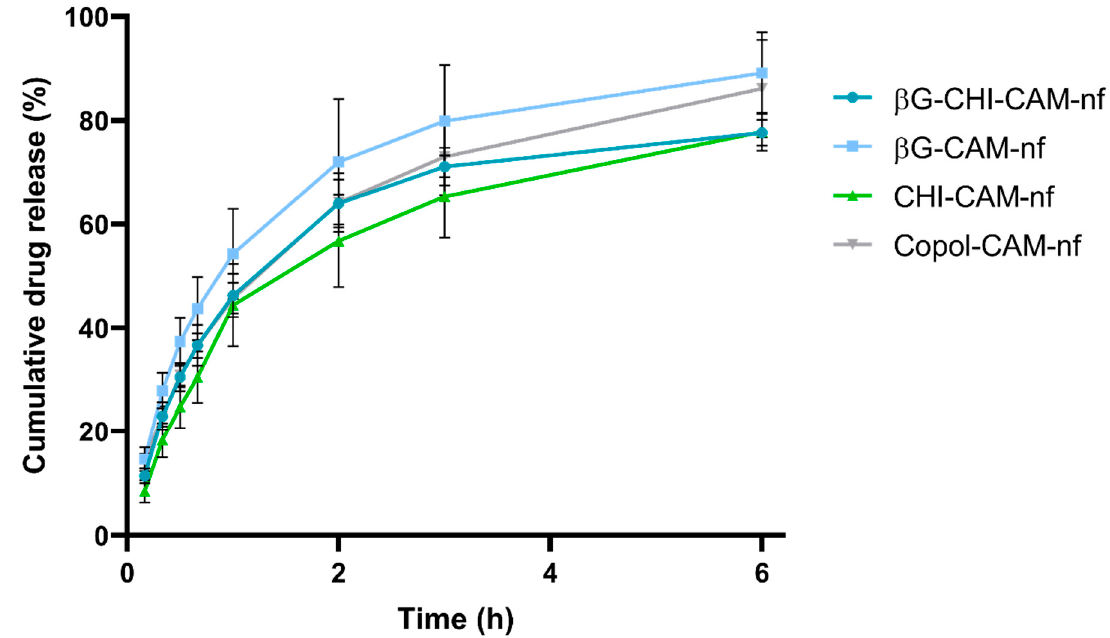
Figure 2. Cumulative release (%) of chloramphenicol from nanofibers during a 6 h test-period in a Franz diffusion setup. Abbreviations: β G ( β -glucan), CHI (chitosan), Copol (co-polymers: polyethylene oxide and hydroxypropylmethylcellulose), CAM (chloramphenicol), nf (nanofibers). Results are presented as mean ± SD ( n = 3).